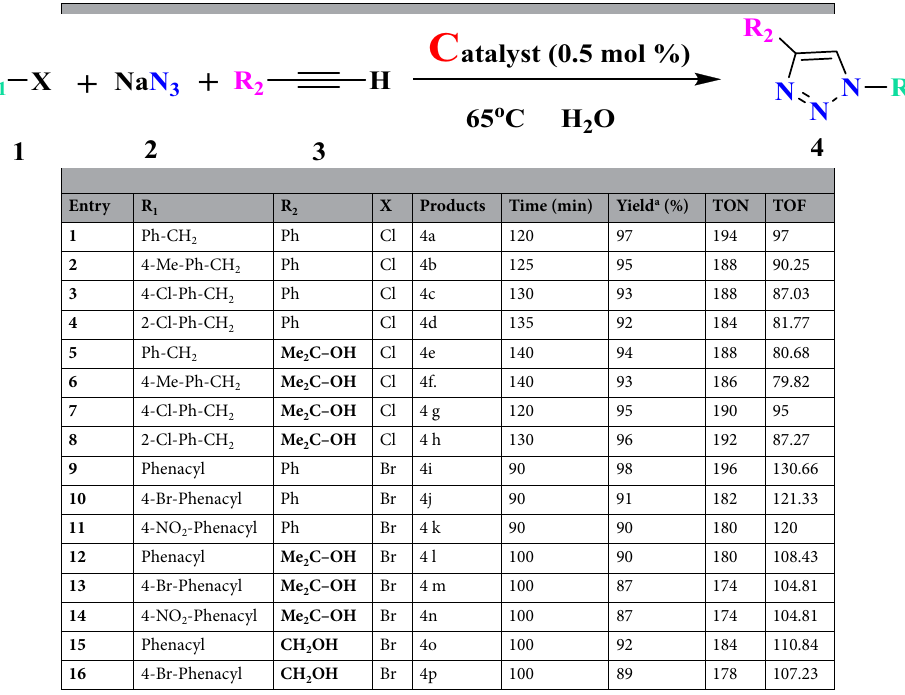
Table 2. Multi-component synthesis of 1,2,3 ‐ triazole derivatives at 65 °C temperature using water as solvent